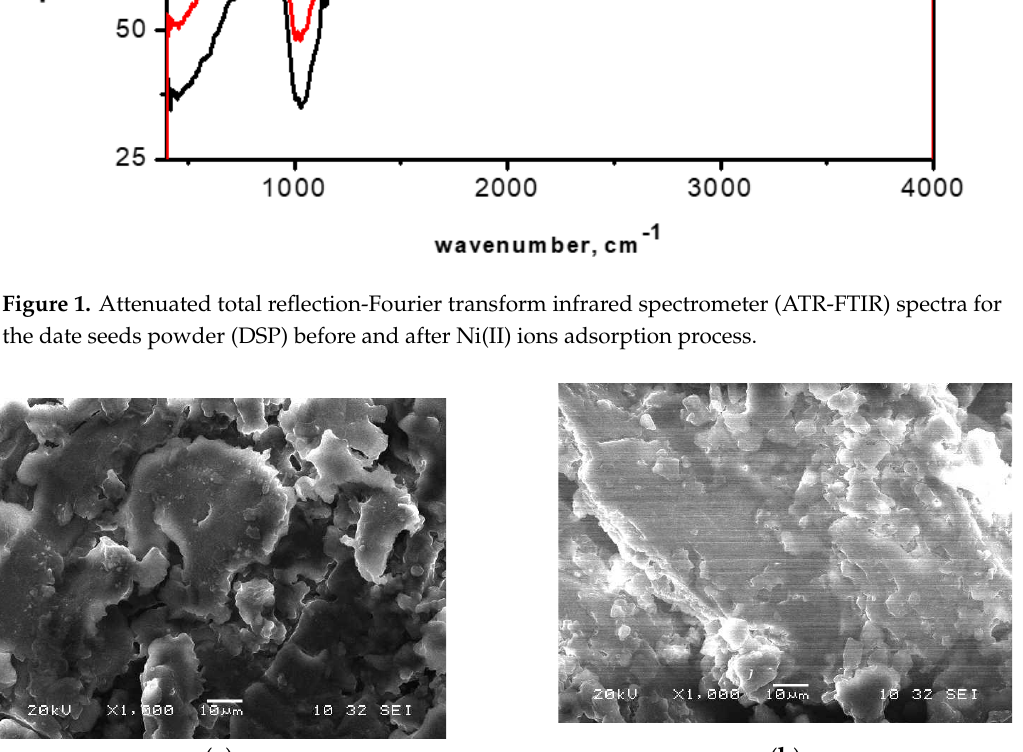
Figure 1. Attenuated total reflection-Fourier transform infrared spectrometer (ATR-FTIR) spectra for the date seeds powder (DSP) before and after Ni(II) ions adsorption process.